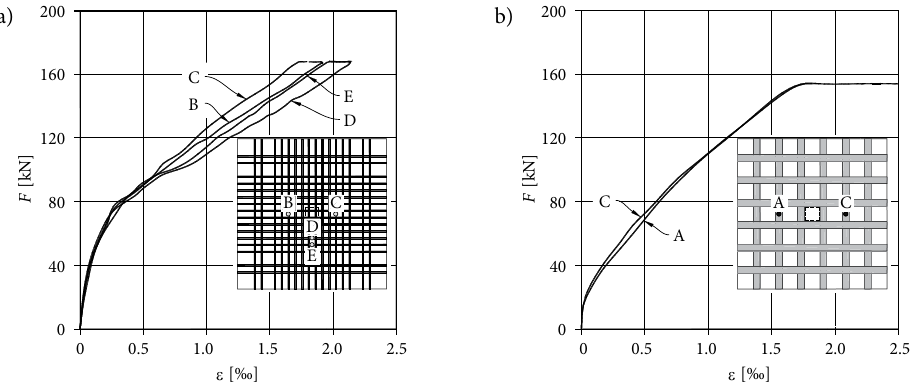
Figure 2. Comparison of strains of the CFRP external reinforcement in the form of: a) injected flat bars (BCN1), b) adhesive strips glued on the slab surface (BCG1), according to Moreno et al. (2015)